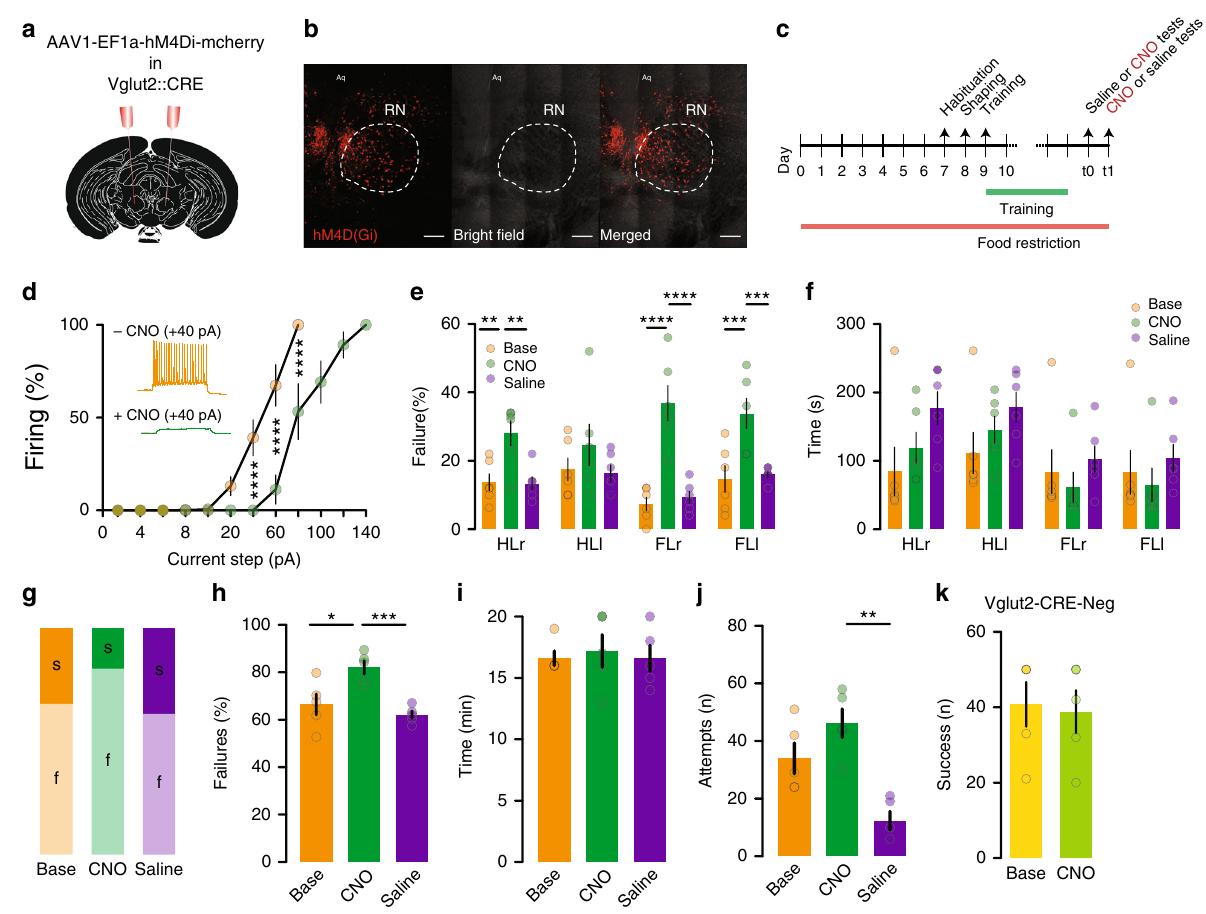
Fig. 7 Vglut2-positive neurons are necessary for fi ne motor control. a Schematic of hM4D(Gi)-mcherry injection of Vglut2-CRE mice. b Viral expression (Scale bar 200 µ m). c Timeline. d In vitro validation of hM4D(Gi), 2WRM-ANOVA F (1,72) = 62.58, P < 0.0001 ( n = 7 cells). e Failure rate in the EGT, 2WRM-ANOVA F (2,40) = 40.14, P < 0.0001 ( n = 6 mice) (HL: hindlimb, FL: forelimb, r: right, l: left). f Completion time. g Performance in the SPRT. h Failure rate, 1WRM-ANOVA F (1.5,6) = 28.23, P = 0.0012. i Completion time. j Total attempts, 1WRM-ANOVA F (1.5,6.1) = 11.68, P = 0.01. k Vglut2-CRE- negative mice success rate ( n = 6 mice). All data are reported as mean and SEM. Baseline performance are depicted in orange or yellow, performance after CNO injection are shown in dark or light green and performance after saline injection are displayed in